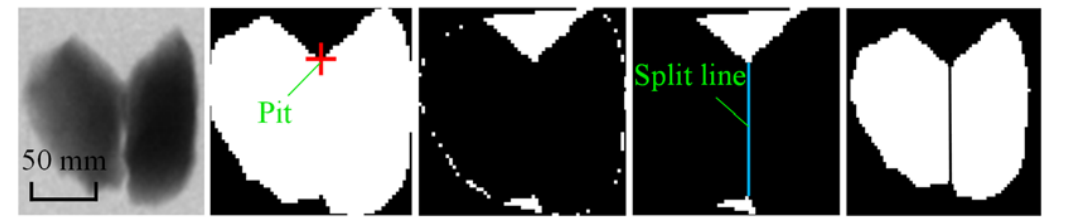
Figure 11. Single pit dividing line acquisition process.